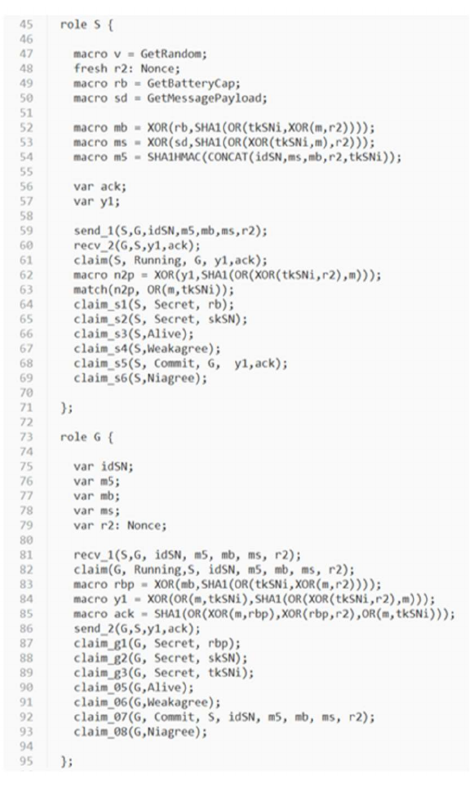
Figure 7. The spdl script for the static authentication phase of the proposed protocol.